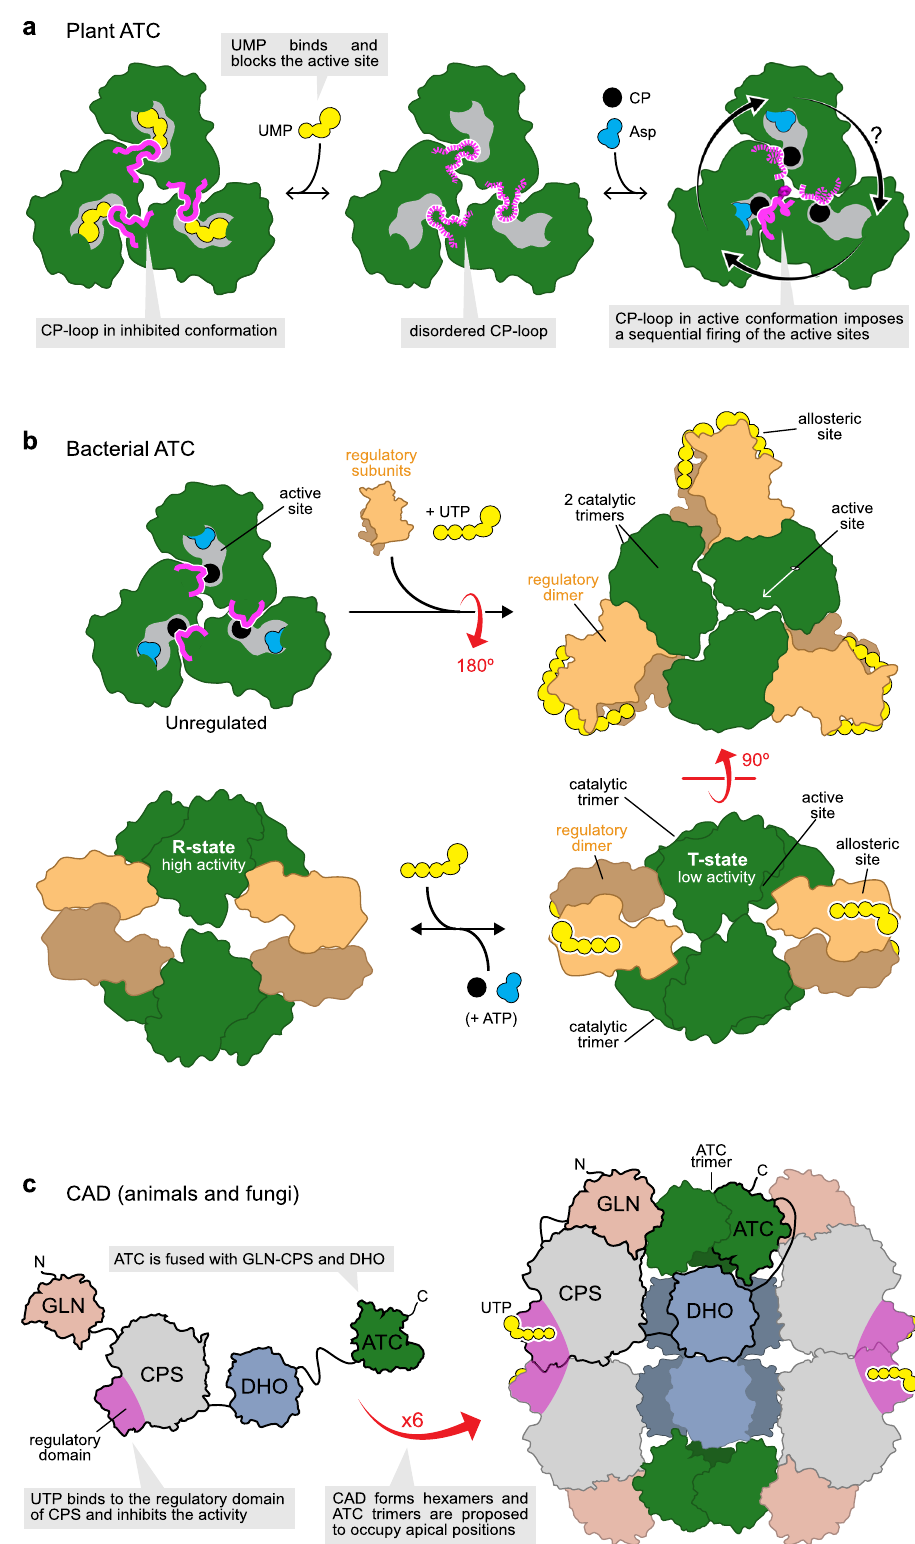
Fig. 6 Different regulatory mechanisms in ATC. a Plant ATCs present a unique mechanism of regulation, where UMP binds and blocks the active site. The CP-loop (represented in magenta) alternates between an UMP-bound inhibited conformation and an active conformation that ensures the sequential and perhaps ordered fi ring of the active sites. b In bacteria, isolated ATC catalytic trimers are unregulated. The association of two catalytic trimers with three dimers of regulatory subunits results in a holoenzyme that undergoes large conformational changes upon binding of UTP (inhibitor) or ATP (activator) to allosteric sites in the regulatory subunits. c In eukaryotes other than plants, ATC is fused together with CPS and DHO into a single multienzymatic protein named CAD that oligomerizes into hexamers where ATC trimers are proposed to occupy apical positions. The CPS and ATC activities are regulated by the binding of UTP to a regulatory region within the CPS